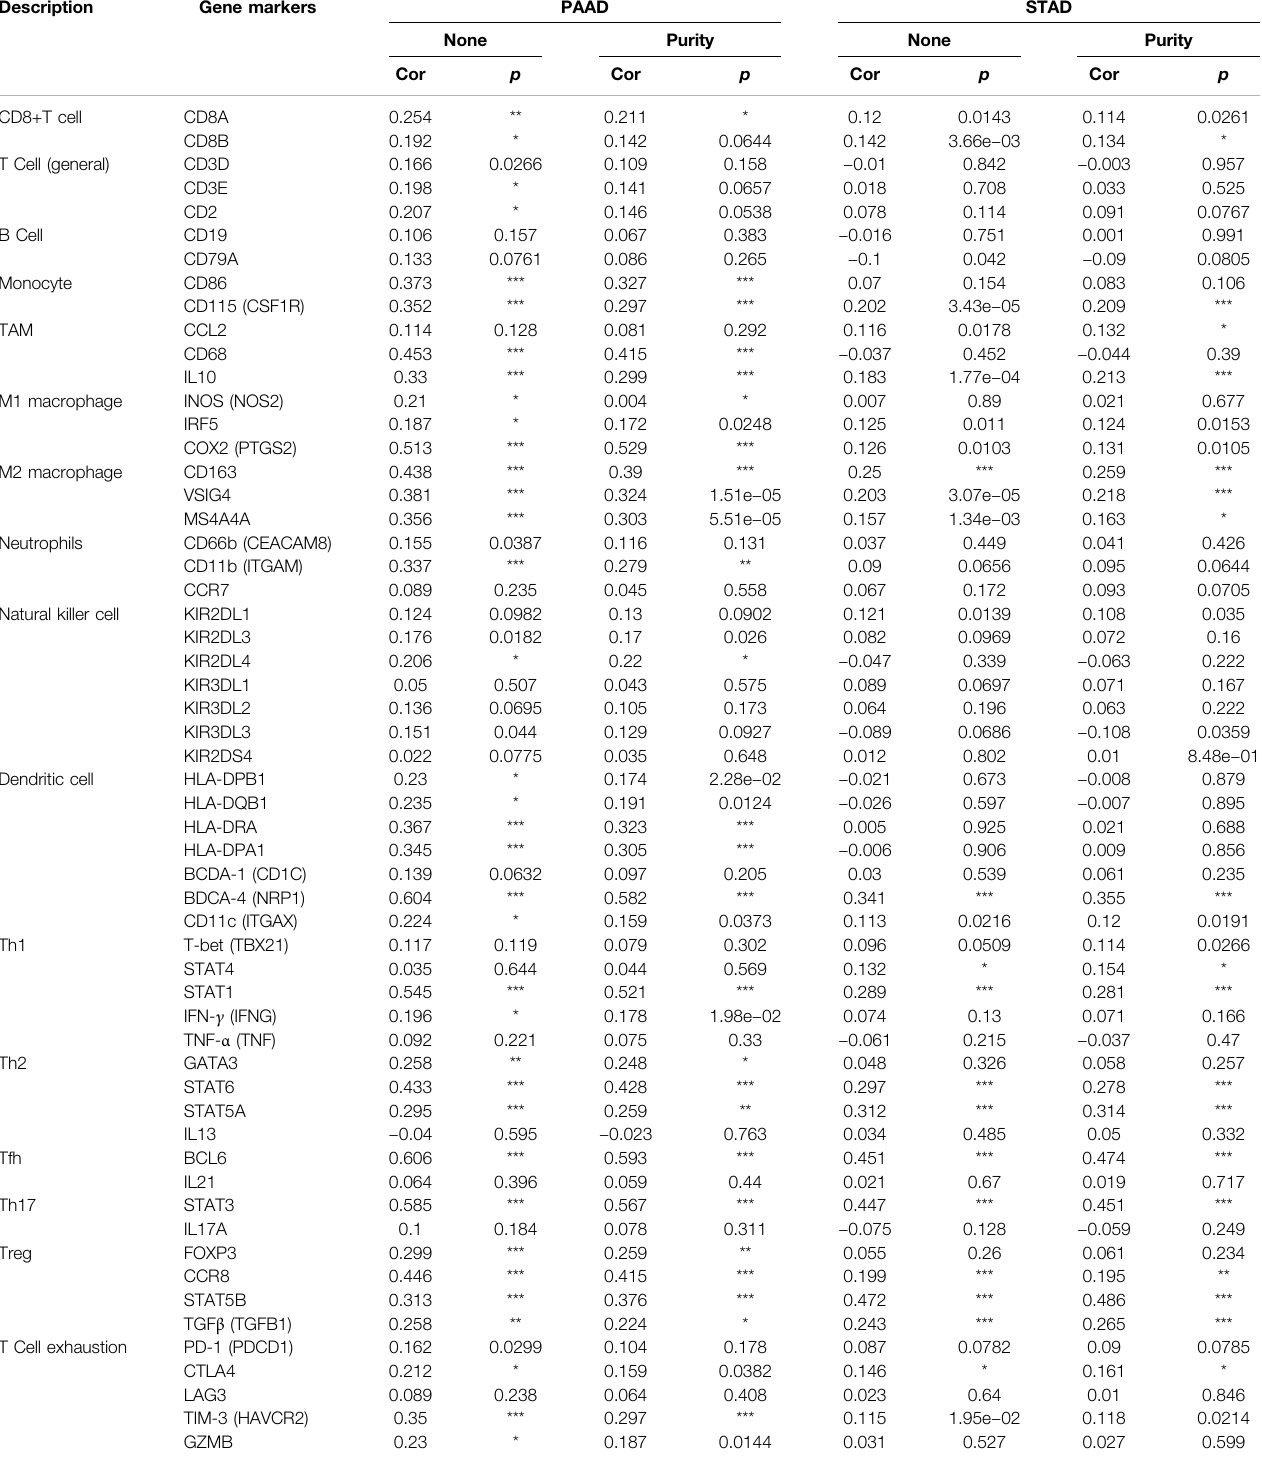
TABLE 2 | Correlations between YAP1 and markers of immune cells in TIMER.